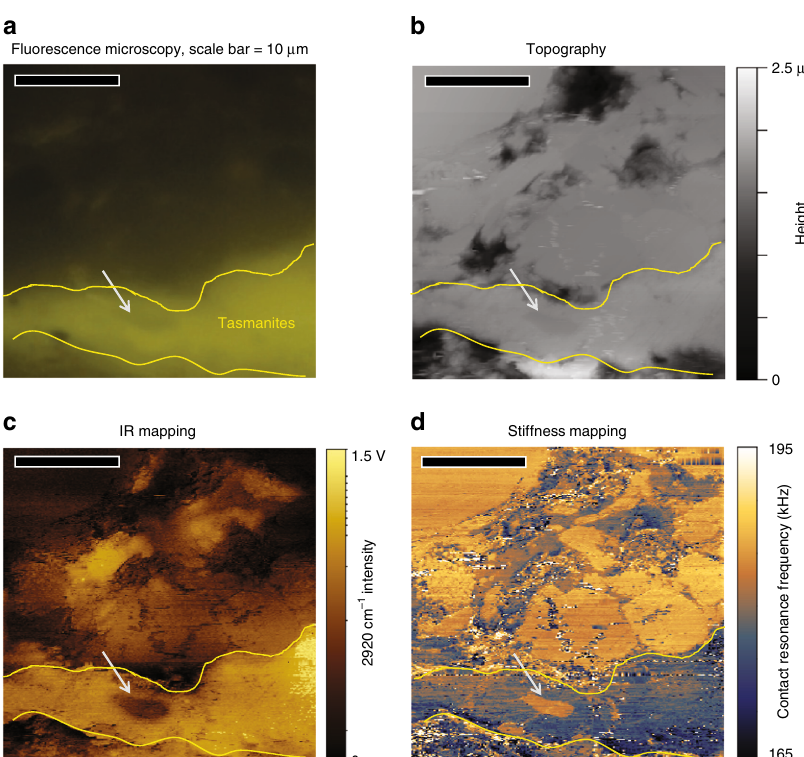
Fig. 2 Correlative imaging of Tasmanites . Correlative imaging and atomic force microscopy infrared spectroscopy (AFM-IR) characterization, where the Tasmanites is outlined in yellow with one small mineral particle (indicated by the gray arrow) entrained inside: a fl uorescence microscopy, showing brightly fl uorescing Tasmanites , b topographic image, c IR absorption mapping at 2920 cm − 1 , d mechanical stiffness mapping at 2920 cm −